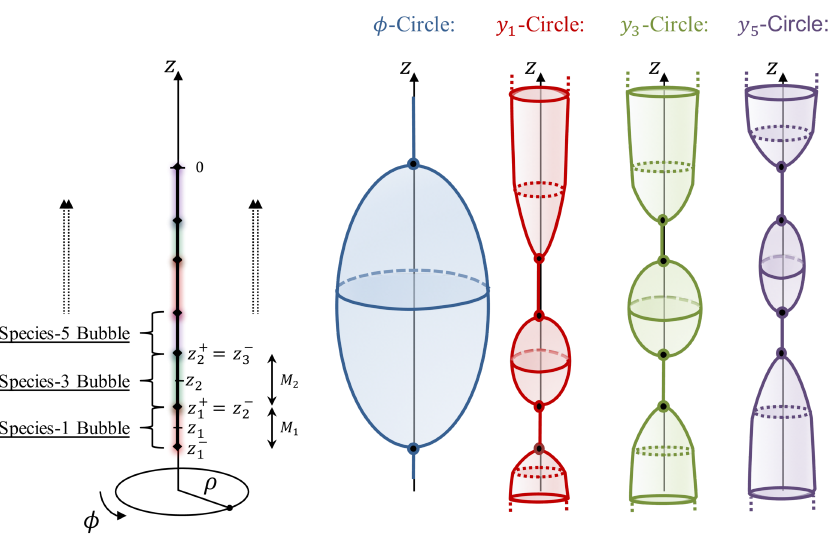
Figure 7 . Description of a chain of smooth M2-KKm bubbles in M-theory and the behavior of the φ , y 1 , y 3 and y 5 circles on the z -axis (the other fibers have finite size everywhere). The species- k bubble rod corresponds to the degeneracy of the y -circle as an origin of a R 2 k